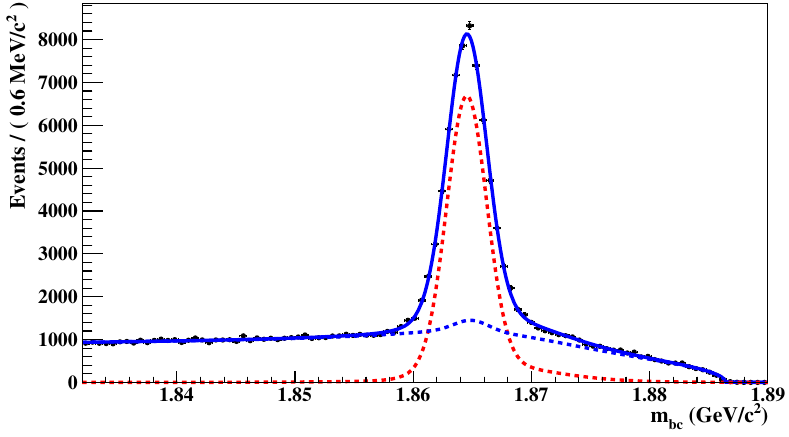
Figure 7 . m bc distribution for single-tagged D ! K 0 the solid blue curve is the total (cid:12)t and the dashed red and blue curves are signal and background (cid:12)t components,